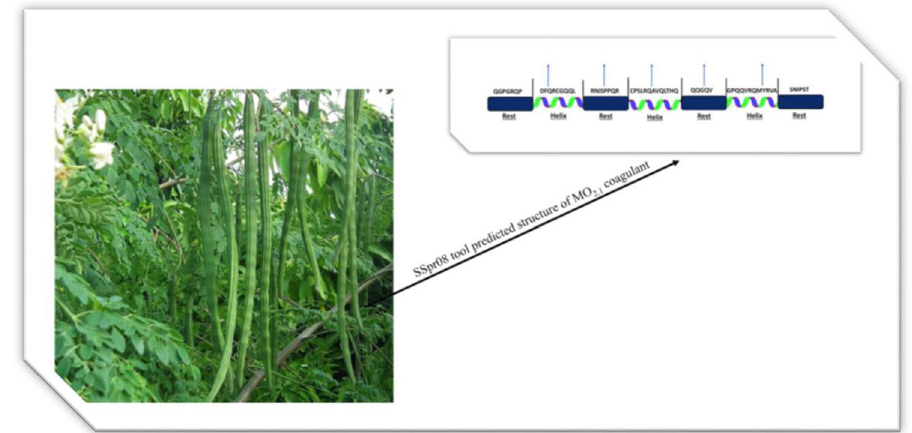
Fig. 16 Moringa seed protein powder as a